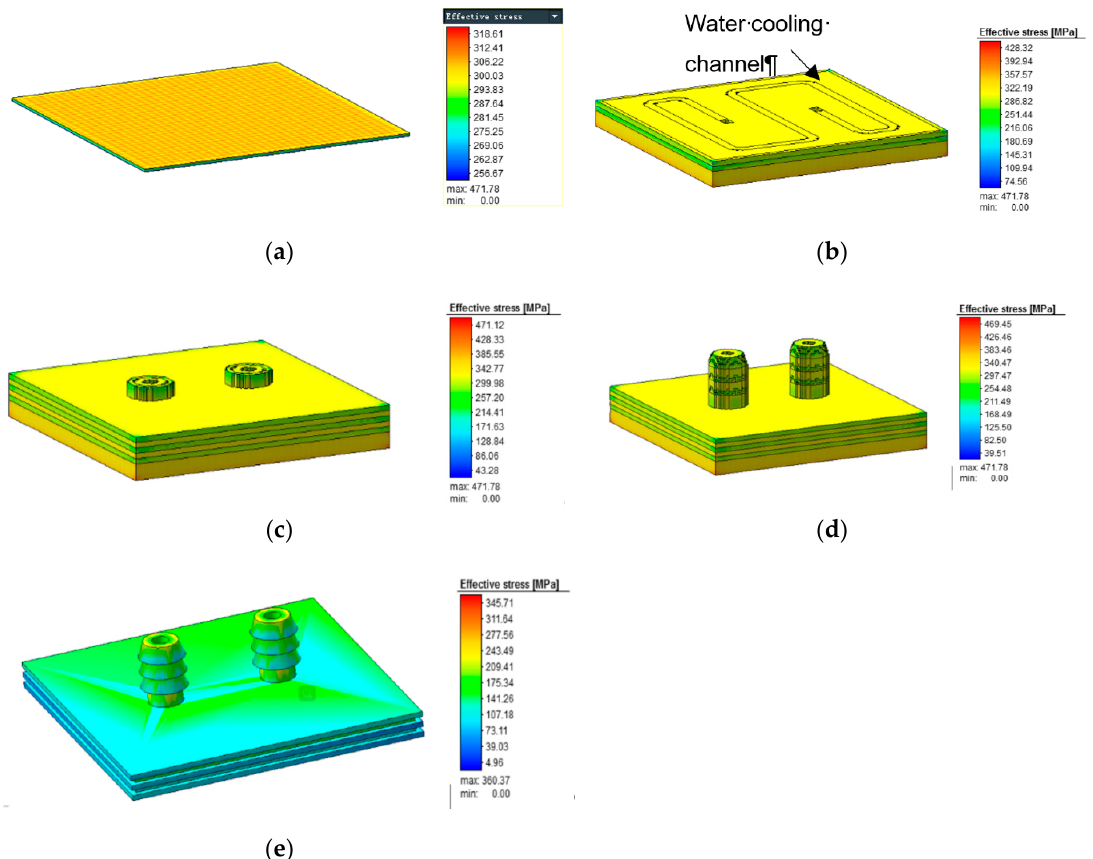
Figure 4. Phase results of simulation. ( a ) First stage—support formation; ( b ) second stage—water cooling channel formation; ( c ) third stage—nozzle formation; ( d ) fourth stage—formation of the entire part; ( e ) fifth stage—support